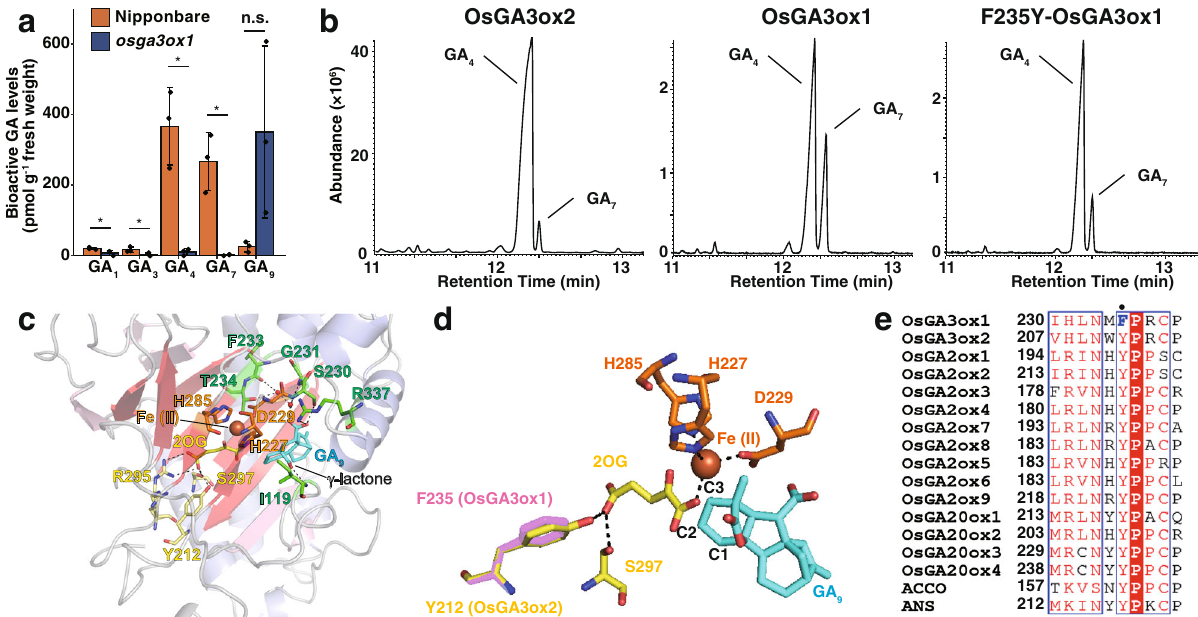
Fig. 1 Activity of rice GA3ox1 and GA3ox2 upon synthetic gibberellic acid, and their structural factors. a Endogenous GA levels in anthers of wild-type (cultivar Nipponbare) and osga3ox1 mutant. Error bars, s.d. n = 3 Student ’ s t test (** p < 0.05). b Gas chromatogram of the reaction mixture for OsGA3ox2 (left panel), OsGA3ox1 (middle panel), and the OsGA3ox1-F235Y mutant protein (right panel) as a substrate GA 9 . The positions of the products GA 4 and GA 7 are indicated. c Structures of OsGA3ox2 around the GA-binding site with GA 9 and the co-substrates, Fe (II), and 2OG (see also Supplementary Figs. 4 – 6). Fe (II) is represented as an orange sphere and 2OG and GA 9 are indicated in yellow and blue, respectively. The amino acids establishing interactions with Fe (II) (H227, D229, and H285), 2OG (Y212, R295, and S297), and GA 9 (I119, S230, G231, F233, T234, and R337) are shown in orange, yellow, and green, respectively. d Structural comparison of the active sites of OsGA3ox2 and OsGA3ox1 (predicted structure). Important amino acids are shown with the same colors and numbers as in ( c ) (OsGA3ox2). The site with amino acid Y212 or F235 in the 2OG-interacting site is responsible for the substitution in OsGA3ox1 (shown in e ). e Sequence alignment of rice GA oxidase enzymes, OsGA3oxs, OsGA20oxs, OsGA2oxs, and other 2ODD family proteins, ACCO (ACC oxidase), and ANS (anthocyanidin synthase). The black dot indicates F212 in the 2OG-interacting site of OsGA3ox2 as described for ( c ) and ( d